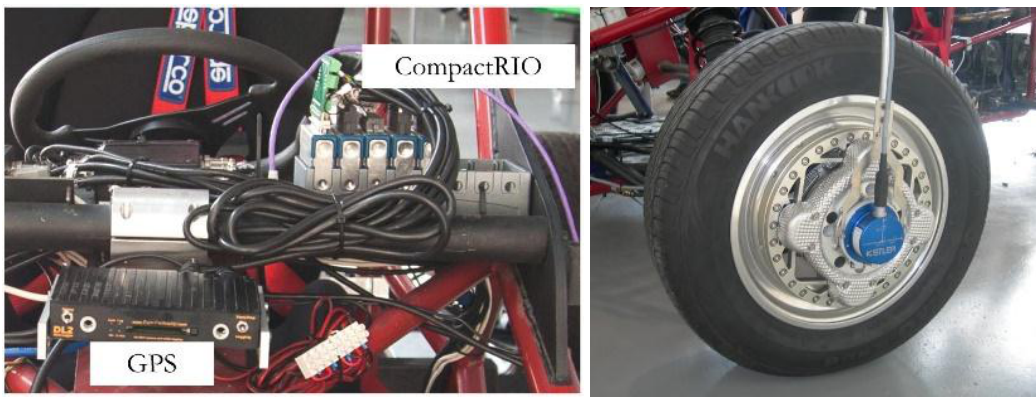
Figure 18. Data acquisition and control system ( Left ) and wheel force transducer ( Right ).